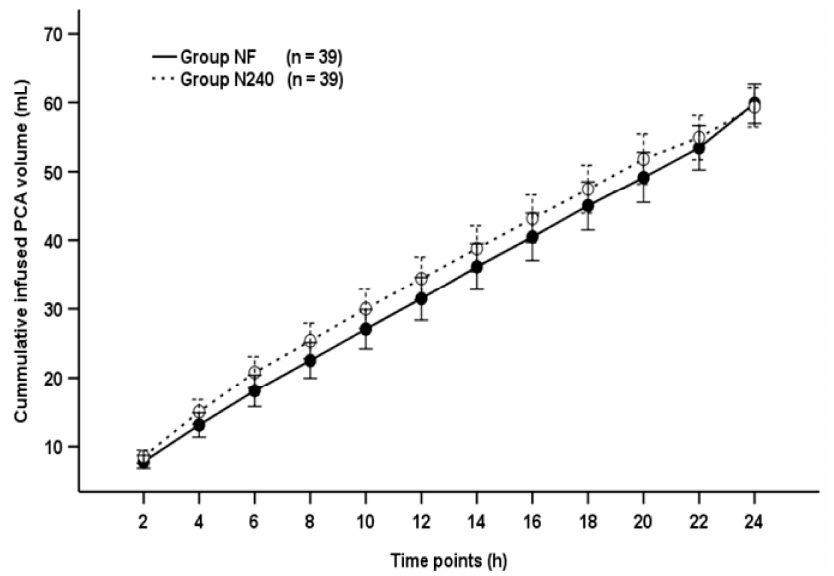
Figure 4. Time-sequential changes of cumulative infused PCA volumes. Data points and error bars represent means and 95% confidence intervals, respectively. Group NF, group receiving nefopam- fentanyl polytherapy; Group N240, group receiving nefopam monotherapy.